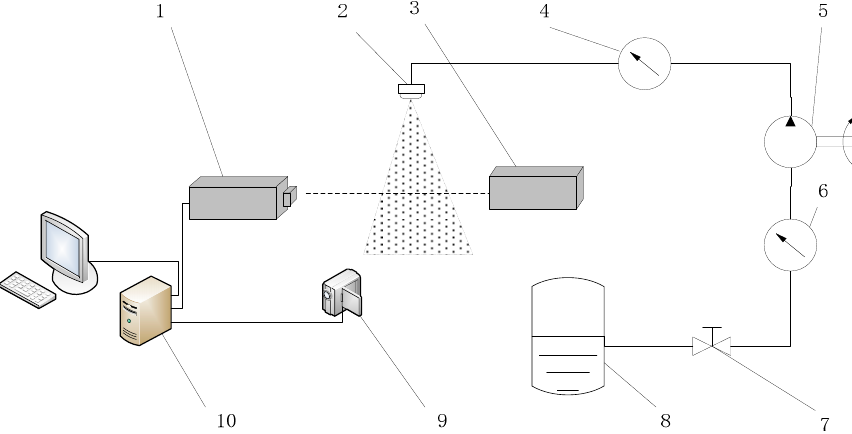
Figure 2. Measurement setup with swirl nozzle and Laser Doppler Anemometry. (1: receiver, 2: swirl nozzle, 3: transmitter, 4: pressure gauge, 5: high pressure pump unit, 6: flow meter, 7: valve, 8: tank, 9: high-speed camera, 10: computer).